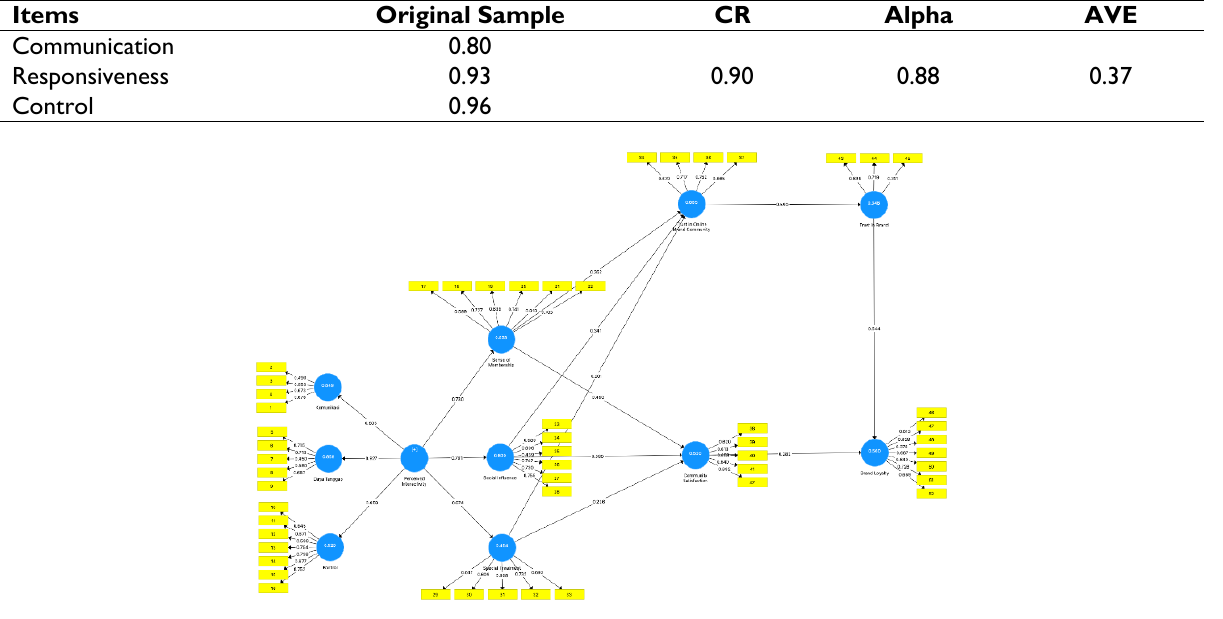
Figure 2. Structural Equation